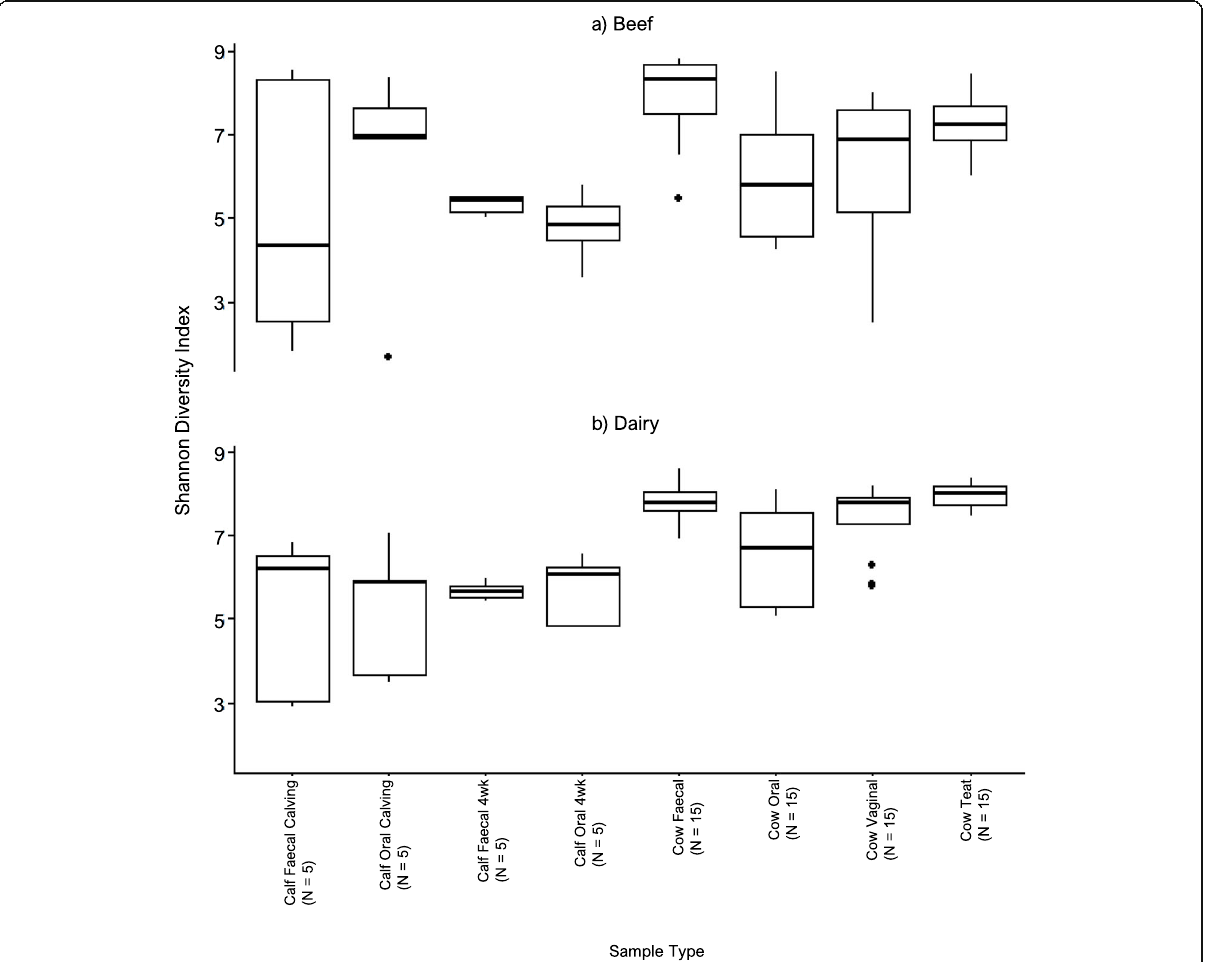
Fig. 2 Shannon diversity index for each sample in beef ( a ) and dairy ( b ) animals. Beef and dairy animals are plotted separately, faecal and oral samples from calves are compared between “ Calving ” (within 12 h of parturition) and “ 4 weeks ” (four-weeks of age). Samples from adult cows are displayed as an average across all three timepoints (six to eight weeks prepartum, within 12 h of parturition, and four-weeks postpartum). The number of individual animals in each group: calf samples N = 5 and adult cow samples N =